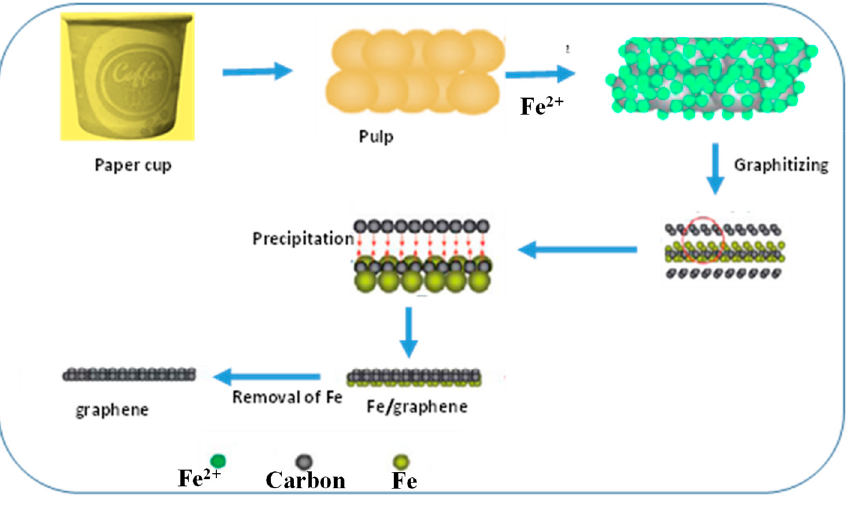
Figure 1. Formation mechanism of graphene sheets from paper cups [25].